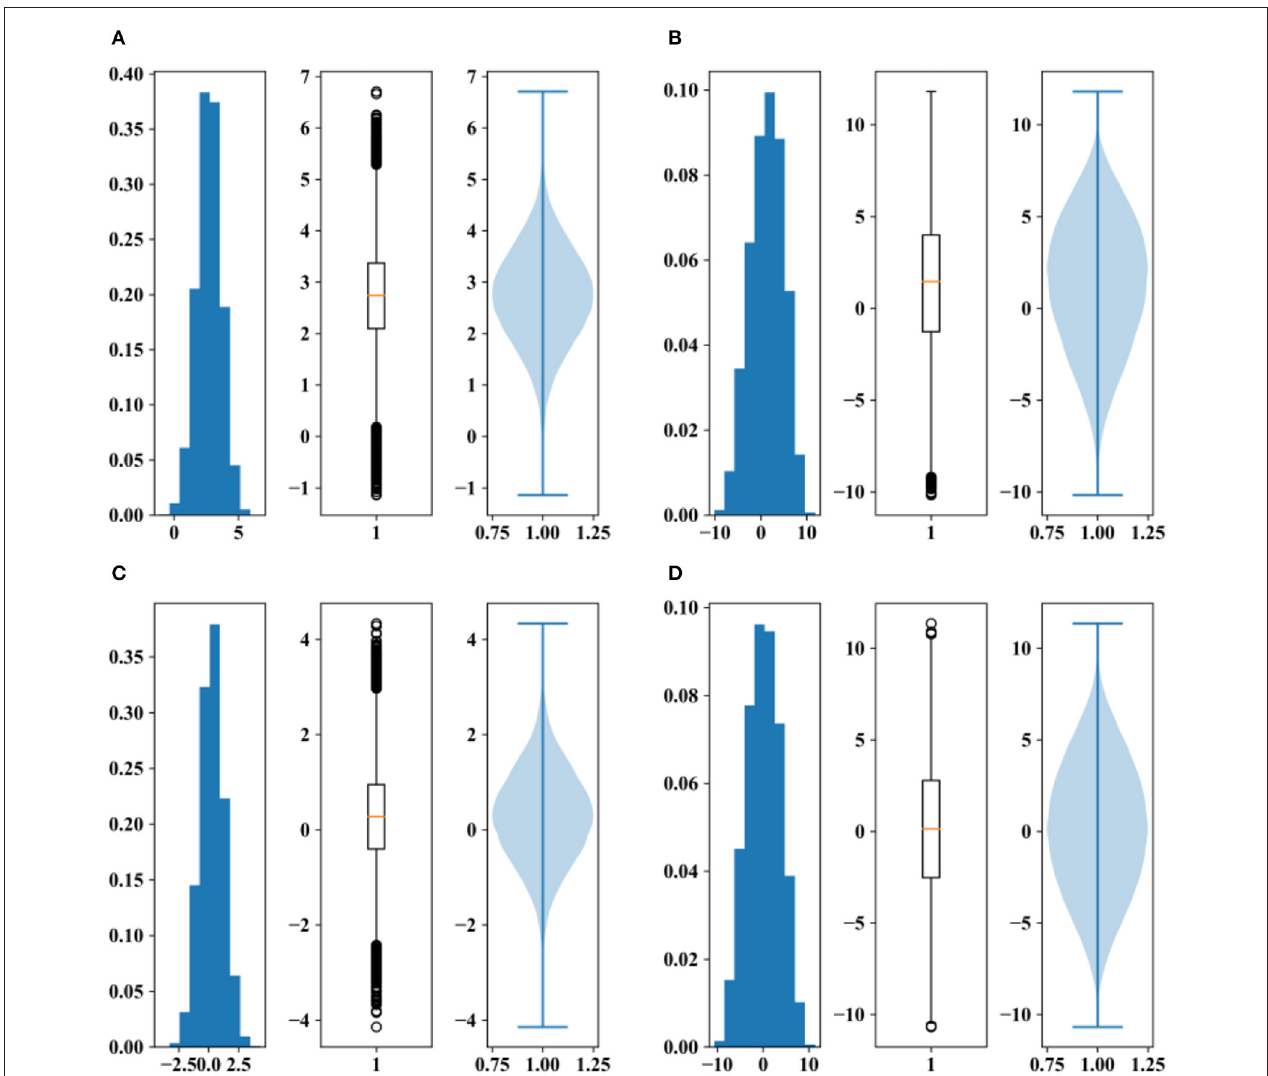
FIGURE 14 | Distributions of the standardized MK statistics, where the sample length is 100 and the slope value is equal to 0.01: (A) PSD coefficient 0; (B) PSD 1, autocorrelation coefficient = =